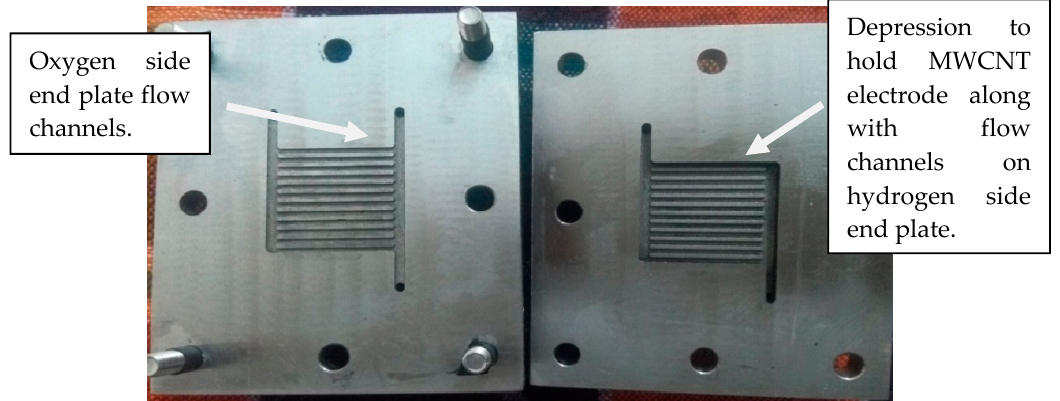
Figure 7. Actual hydrogen and oxygen side end plates of the modified unitized regenerative fuel cell URFC.